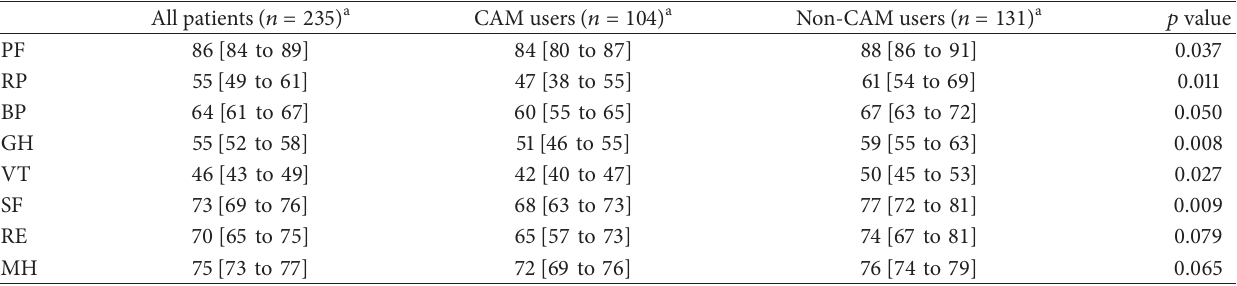
Table 4: Mean SF-36 dimensional scores with 95% confidence intervals in IBD